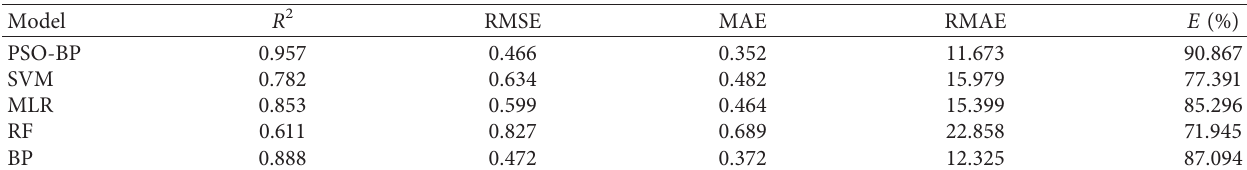
Table 12: R 2 , RMSE, MAE, RMAE, and E (%) results of different